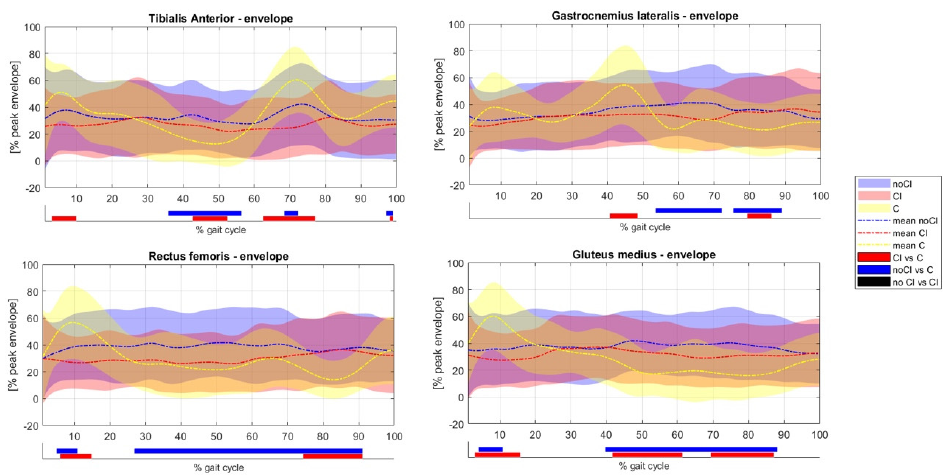
Figure 3. Variables extracted from sEMG signals. From top to bottom, from left to right: mean and standard deviation of the sEMG envelope (Mean value = dashed line, mean ± 1 standard deviation = shaded area) of Tibialis Anterior, Gastrocnemius Lateralis, Rectus Femoris, Gluteus Medius. In yellow, the sEMG values of the control subjects (C); in blue, that of the PN subjects without wearing the custom insole (NoCI); and in red, that of the PN subjects while wearing the custom insole (CI). On the y axis, the envelope values normalized on the peak value detected during gait (% peak en- velope), on the x axis, the gait cycle percentages. At the bottom of each figure: blue bars indicate the instant of the gait cycle where statistically significant differences were detected between C and NoCI; red bars indicate the instant of the gait cycle where statistically significant differences were detected between C and CI; and green bars indicate the instant of the gait cycle where statistically significant differences were detected between NoCI vs. CI ( p < 0.05).